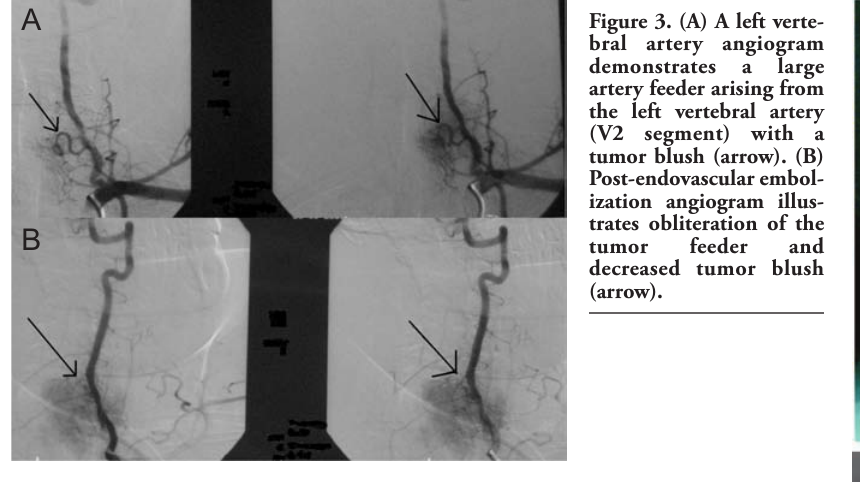
Table 1. Short- and long-term patients' outcomes. Motor One patient continued to have leg weakness. Residual numbness along the medial aspect of both